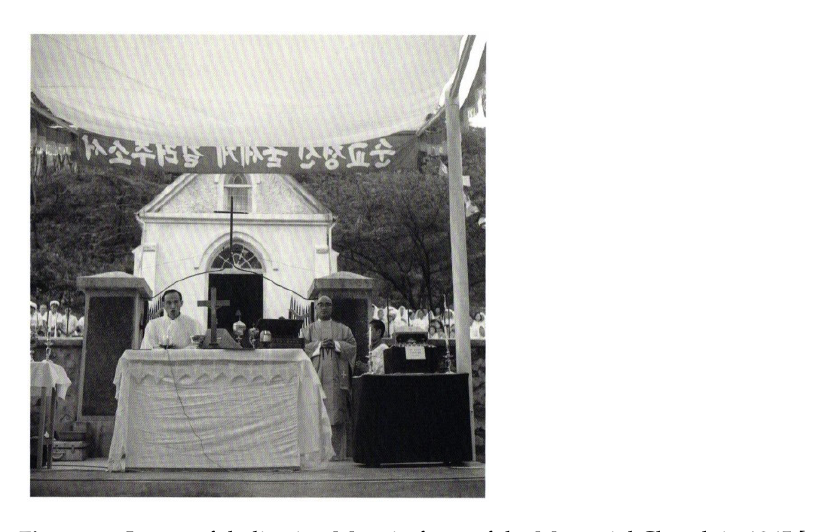
Figure 17. Image of dedication Mass in front of the Memorial Church in 1965 [source: Father Kang Do-Young’s Collection of Letters , p. 579].